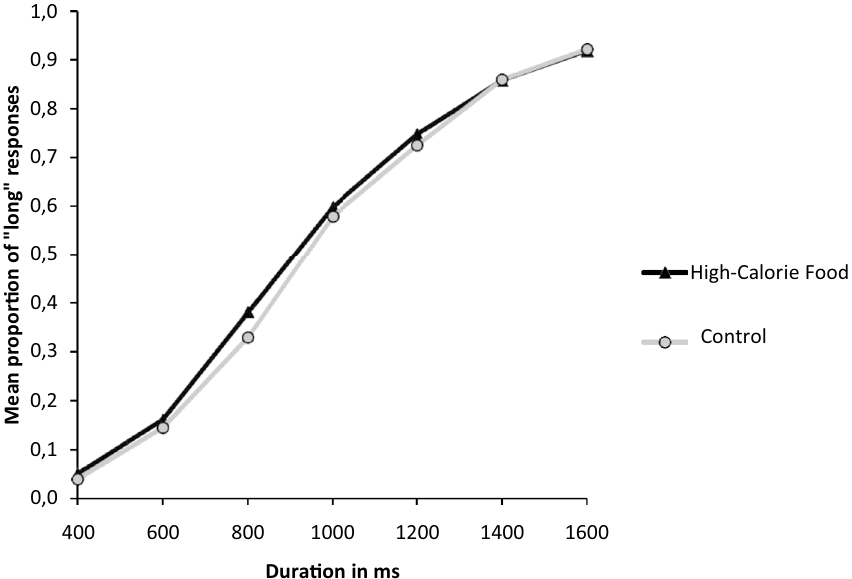
Figure 5. Mean proportion of “long” responses plotted against stimulus duration for high-calorie food and control picture